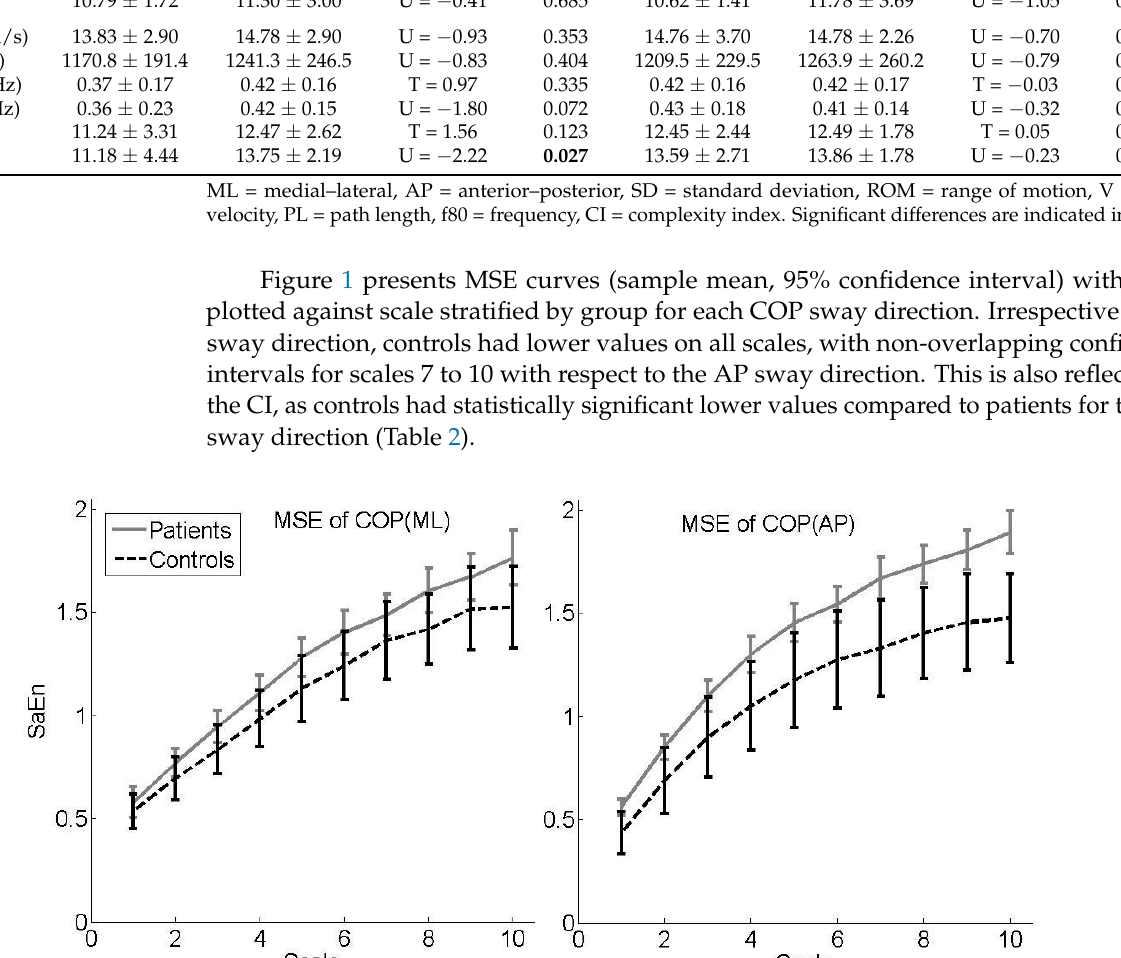
ML = medial–lateral, AP = anterior–posterior, SD = standard deviation, ROM = range of motion, V = mean velocity, PL = path length, f80 = frequency, CI = complexity index. Significant differences are indicated in bold.